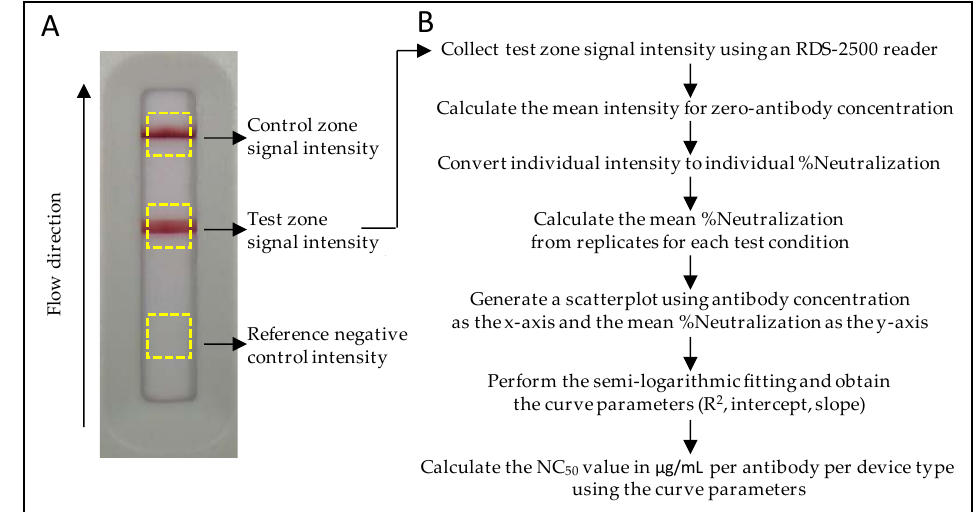
Figure 2. Collection of signal intensities and flowchart for the calculation of NC 50 values from the test line signal intensity. ( A ) An example of a test cassette image recorded by the RDS-2500 LFA reader with designated zones for the collection of signal intensities. ( B ) Flowchart for the calculation of the NC 50 value for each neutralization kinetic curve.